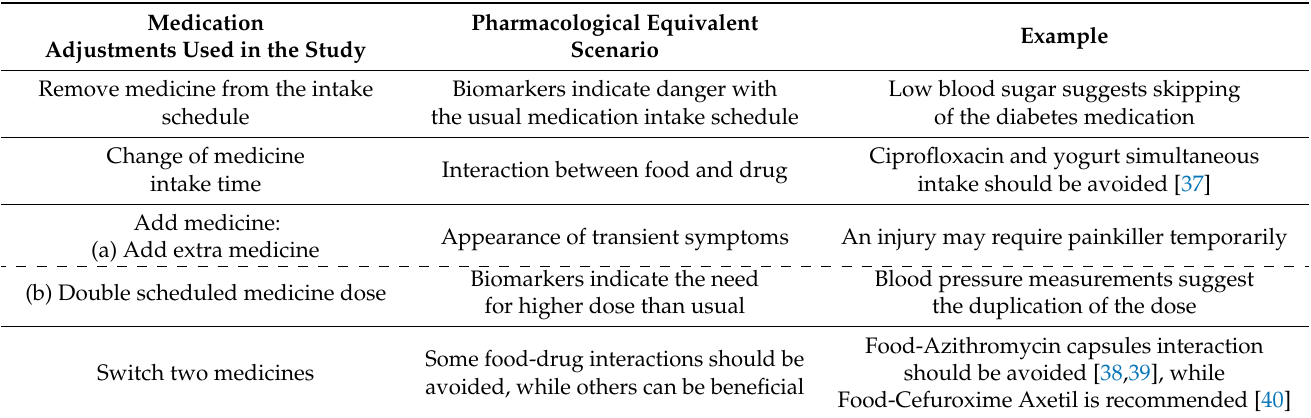
Table 1. Medication Schedule